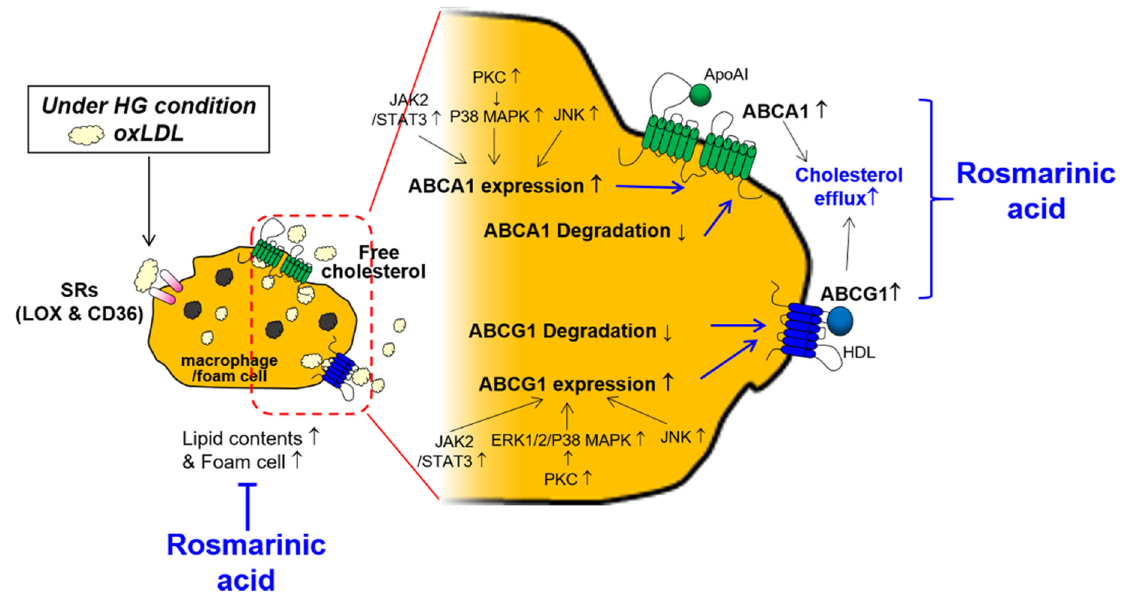
Figure 7. Schematic of the mechanisms by which RA reduces cellular lipid contents and increases cholesterol efflux by macrophages. Rosmarinic acid inhibits foam cells formation by decreasing lipid contents in macrophages and induces cholesterol efflux via upregulating ABC transporters. ↑; increase, ↓; decrease, T; inhibit.